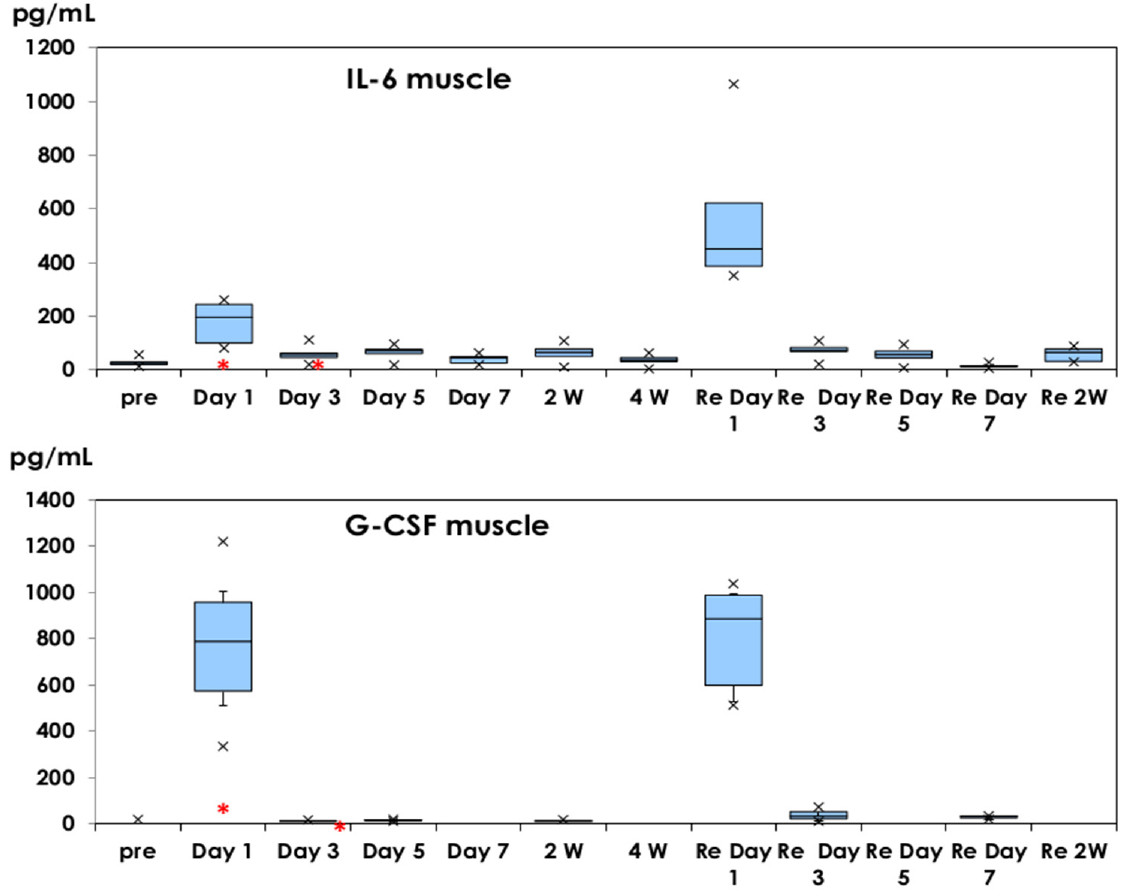
Figure 1. IL-6 and G-CSF production in muscle tissues. They are shown in box-and-whisker plots with median titers and the range of 5–95%. Samples were obtained before injection, on days 1, 3, 5, and 7, and at 2 and 4 weeks after the first dose. The second dose was administered at 4 weeks and samples were obtained based on the same schedule. *: mean concentration of five mice as a control on day 1 of physiological saline injection. ×: outliers.